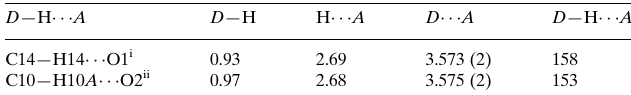
Hydrogen-bond geometry (A˚ , (cid:2)